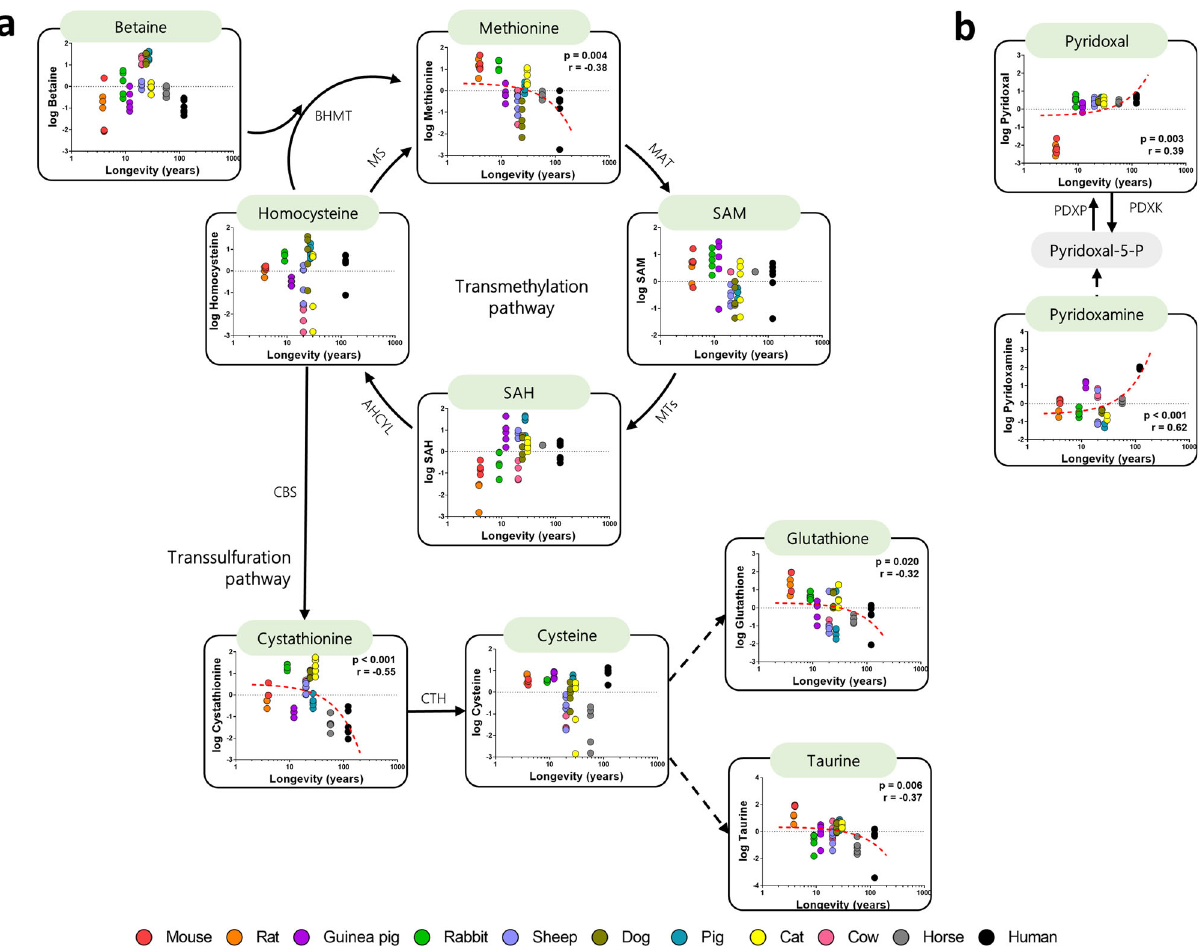
Fig. 2 Plasma methionine-related metabolites and its correlation with animal longevity. Individual plasma correlation of the metabolites with animal longevity involved in the transmethylation and transsulfuration pathways ( a ) and vitamin B6 metabolites ( b ). Dashed lines refer to reactions in which more than one enzyme is involved. Grey-shaded boxes refer to non-detected metabolites. Pearson correlation was performed. Minimum signi fi cation level was set at p < 0.05. All metabolites were log-transformed in order to accomplish the assumptions of normality. Data values are obtained from four (mice and cows), fi ve (rats, rabbits, guinea pigs, sheep, dogs, pigs, cats and horses) or six (humans) specimens. Enzyme codes refer to: MS methionine synthase, BHMT betaine-homocysteine S-methyltransferase, MAT methionine adenosyltransferase, MTs methyltransferases, AHCYL